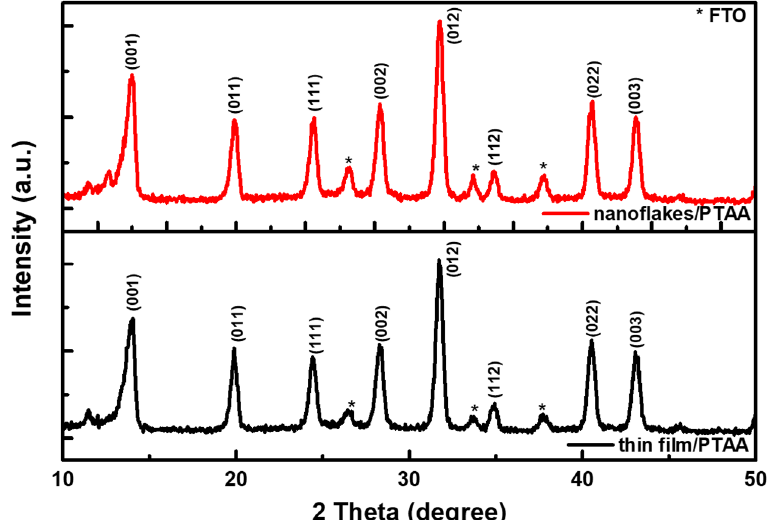
Figure 8. XRD patterns of the perovskite films on the NiO x thin film/PTAA and